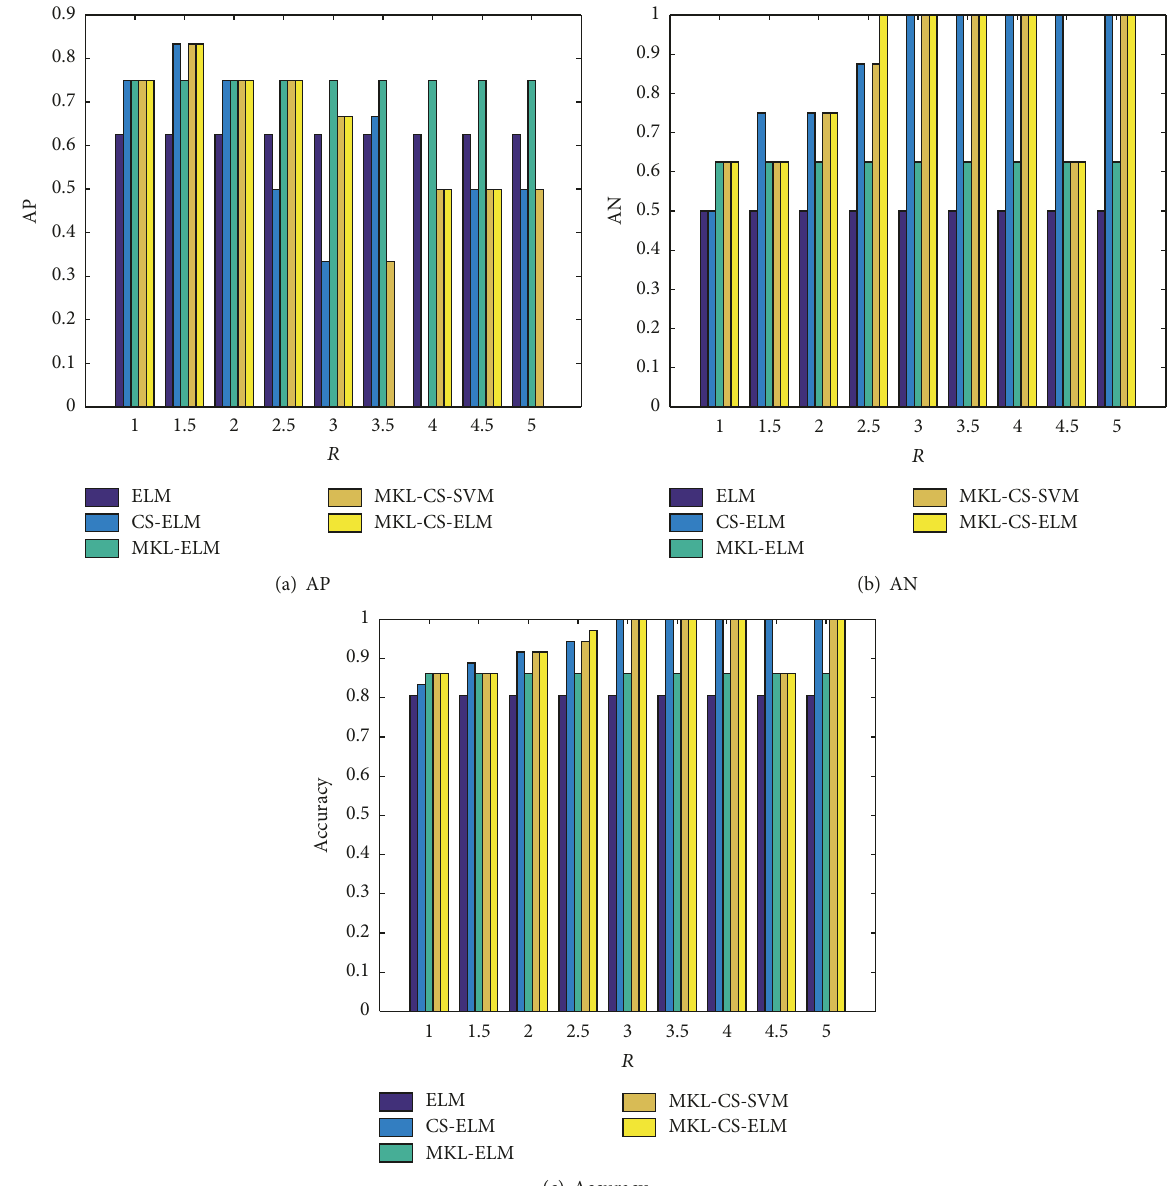
Figure 7: The recognition results of five classification models in